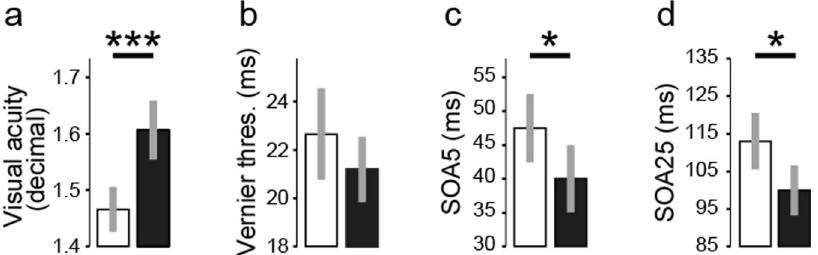
Figure 3. Sample A (Table 1): performance of females (white) and males (black) on the Freiburg visual acuity test ( a ), vernier discrimination ( b ), adding the 25 elements mask (SOA25) ( c ) or the 5 elements mask (SOA5) ( d ). Females have significantly lower visual acuity on The Freiburg visual acuity task compared to males and needed significantly longer SOAs between the vernier and the mask in order to show 75% accuracy rate. The effect size was medium for visual acuity and small for the remaining two significant tests. Error bars represent ± 2 SE of the mean. * p < 0.05, *** p <